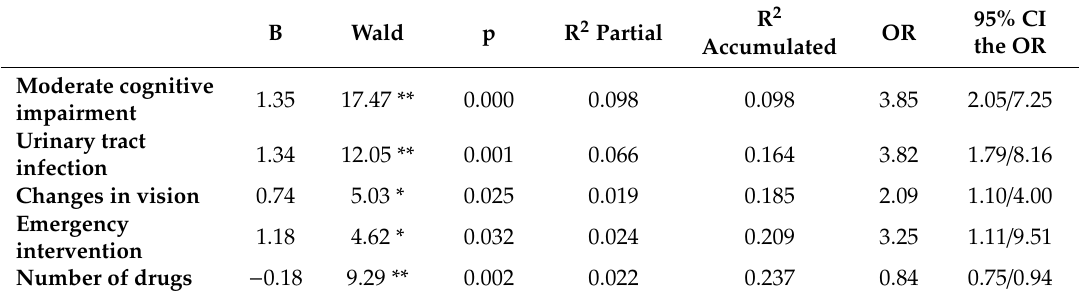
Table 4. Test of independence and multivariate logistic